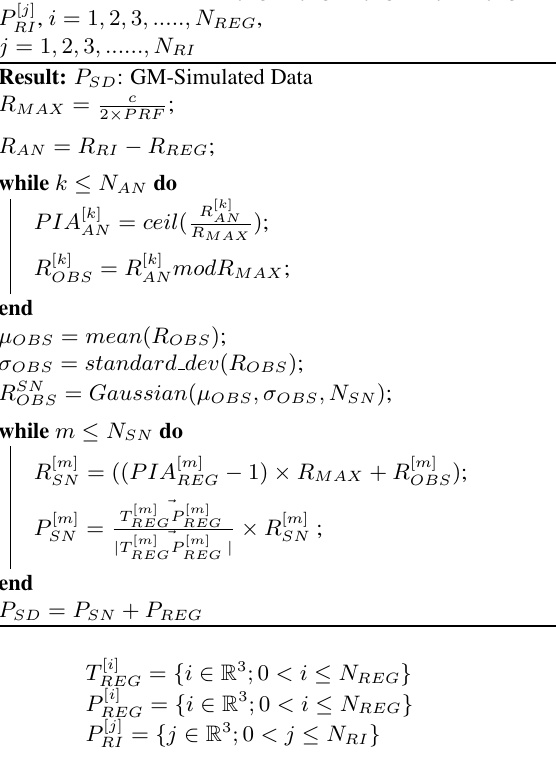
Algorithm 1: Gaussian Model-based